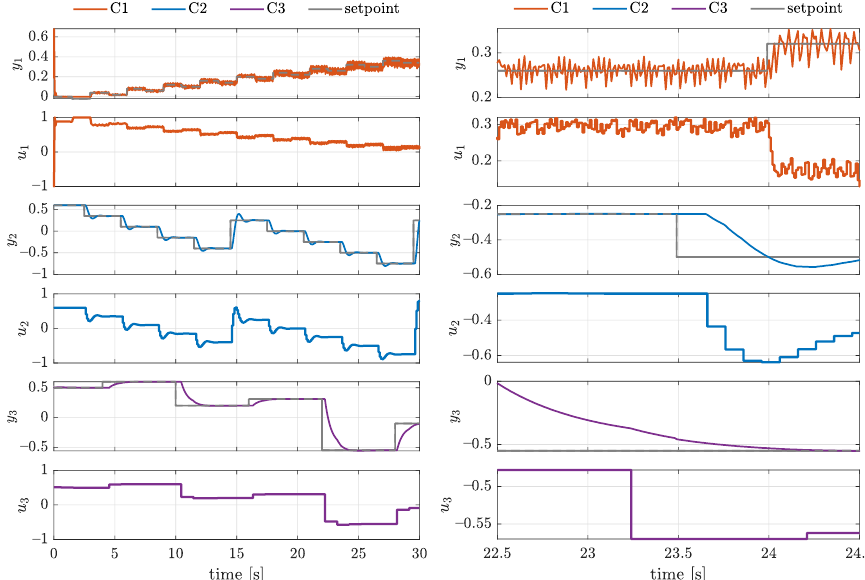
Figure 14. Results of experiment conducted with the servomotor and simulated on FPGA processes, with a sampling period of 10 ms: full experiment ( left ) and zoomed ( right ).